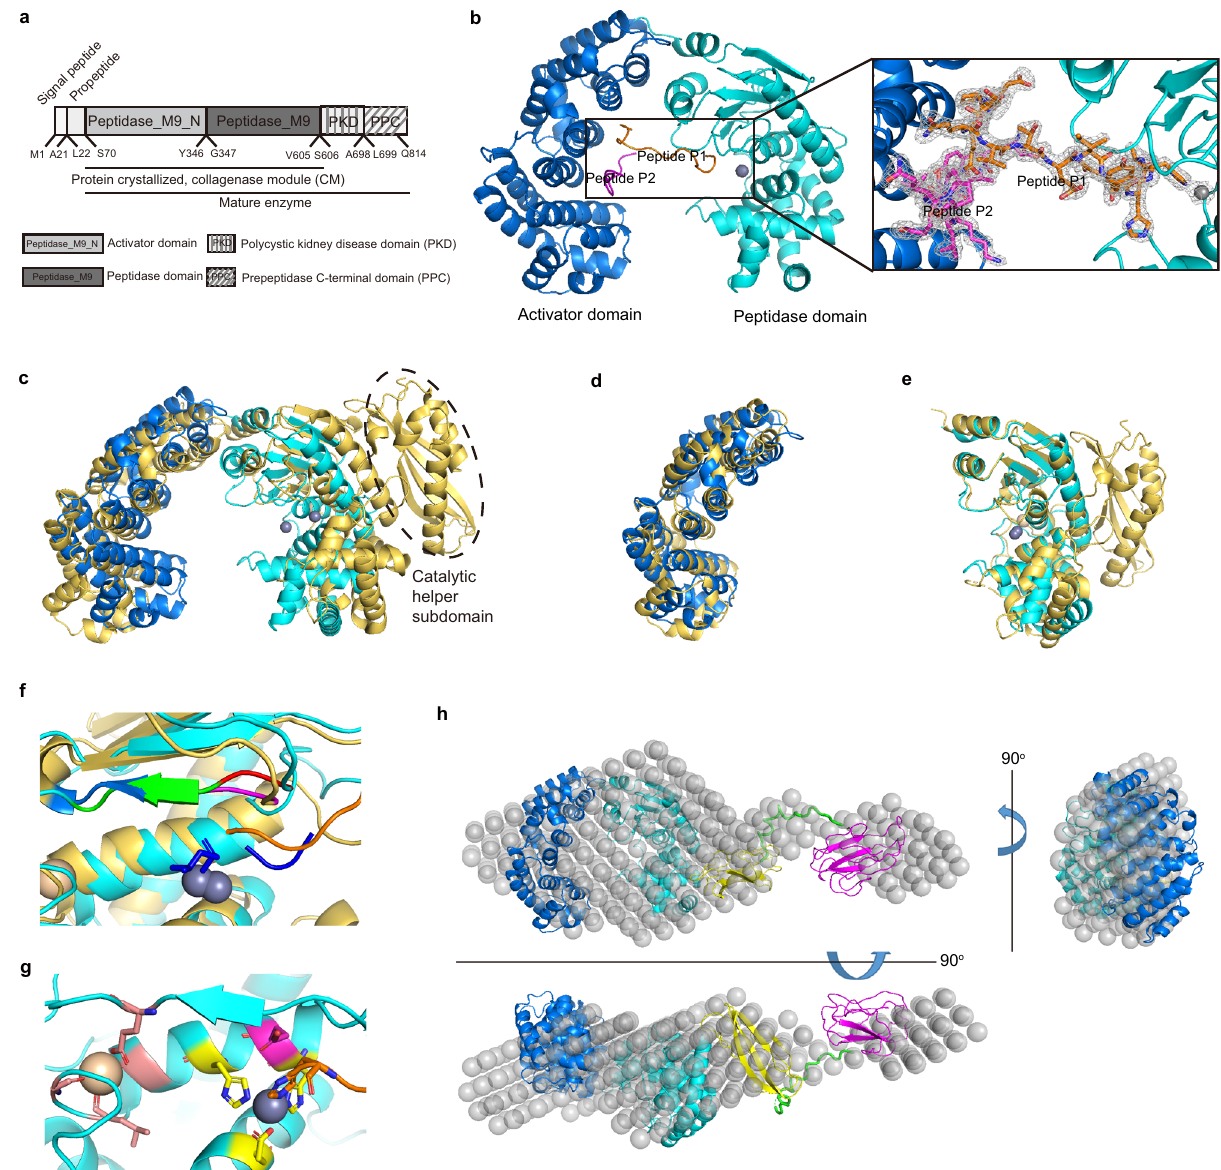
Fig. 1 Crystal structure of the CM and overall conformation of VhaC in solution. a Schematic diagram of the domain organization of VhaC precursor. b The overall structure of CM. The activator domain is shown in marine, and the peptidase domain in cyan. Zn 2 + (gray) and Ca 2 + (wheat) are shown as spheres. Peptides P1 and P2 derived from the propeptide are colored in orange and magenta, respectively. A close-up view of the 2 F o - F c omit electron density map of the peptide P1 (orange sticks), peptide P2 (magenta sticks) and Zn 2 + ion (gray sphere) contoured at 1.0 σ (gray) is shown. c A comparison of the CM structures between VhaC and ColG (golden) (PDB: 2Y50). The catalytic helper subdomain of ColG is indicated by dotted ellipse. d Structural superimposition of the activator domains of VhaC (marine) and ColG (golden). e Structural superimposition of the peptidase domains of VhaC (cyan) and ColG (golden). f Structural superposition of the catalytic centers of CM and 2Y6I. Peptide P1 in CM is colored in orange and isoamyl-phosphonyl-Gly-Pro- Ala in 2Y6I is colored in blue. The double-Gly motif representing the S1 ′ recognition site is shown in red (CM) and magenta (2Y6I). The edge strand representing the non-primed substrate-recognition site is shown in green (CM) and marine (2Y6I). g Ribbon representation of the catalytic center of CM. Residues His477, His481, Glu505 (shown in yellow), and histidine from peptide P1 (shown in orange) tetrahedrally coordinate the catalytic Zn 2 + (gray sphere). The catalytic Glu478 is shown in magenta. The Ca 2 + is coordinated by Gly485, Leu489, Gly491, and Glu446 (shown in salmon). h Superimposition between the ab initio beads model and the rigid body model of VhaC. The beads model is represented as grey spheres. The rigid body model is drawn as a ribbon representation and colored marine (the activator domain), cyan (the peptidase domain), yellow (the PKD-like domain), and magenta (the PPC domain). The poly-glycine linker added by CORAL is shown in